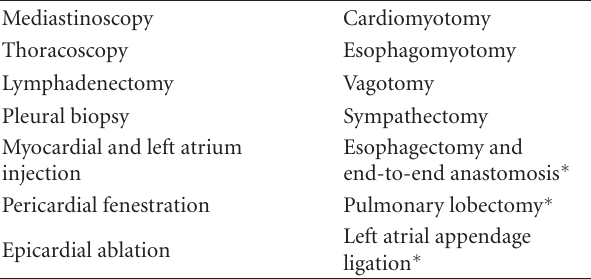
Table 1: Transesophageal NOTES procedures in animal